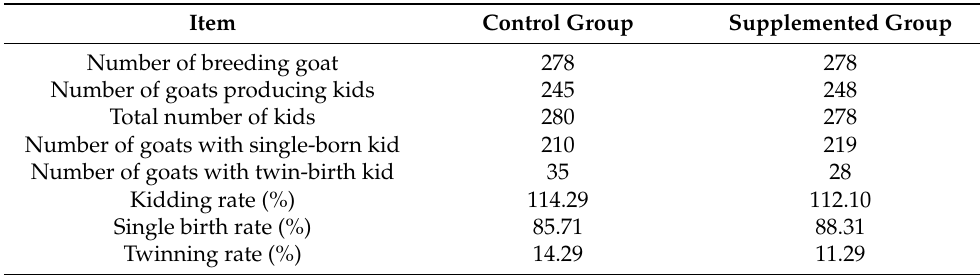
Table 6. Effect of supplementary feeding on kid production.